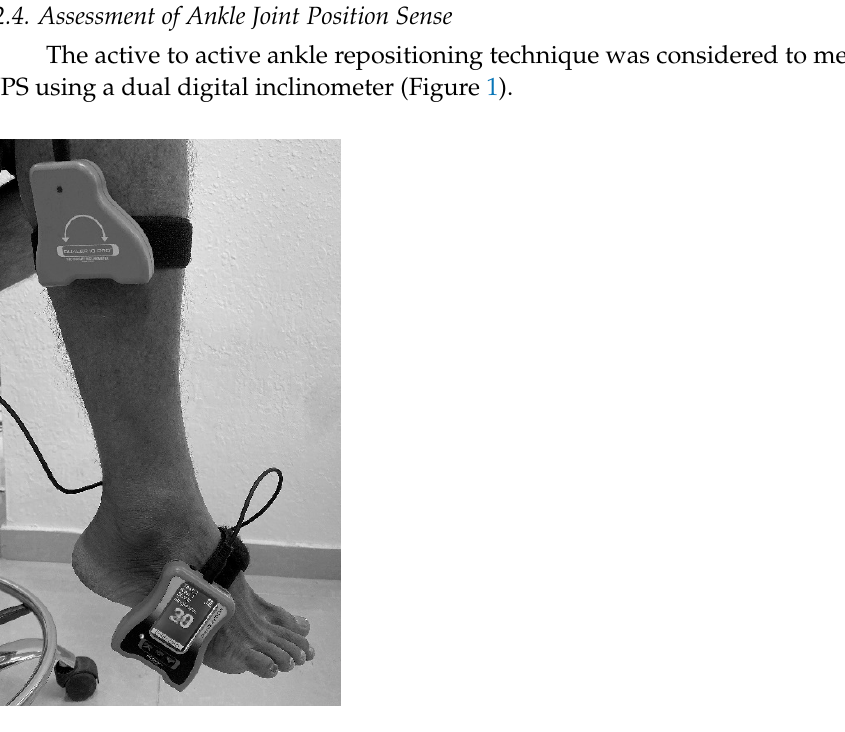
Figure 1. Assessment of ankle joint position sense using a dual digital inclinometer.